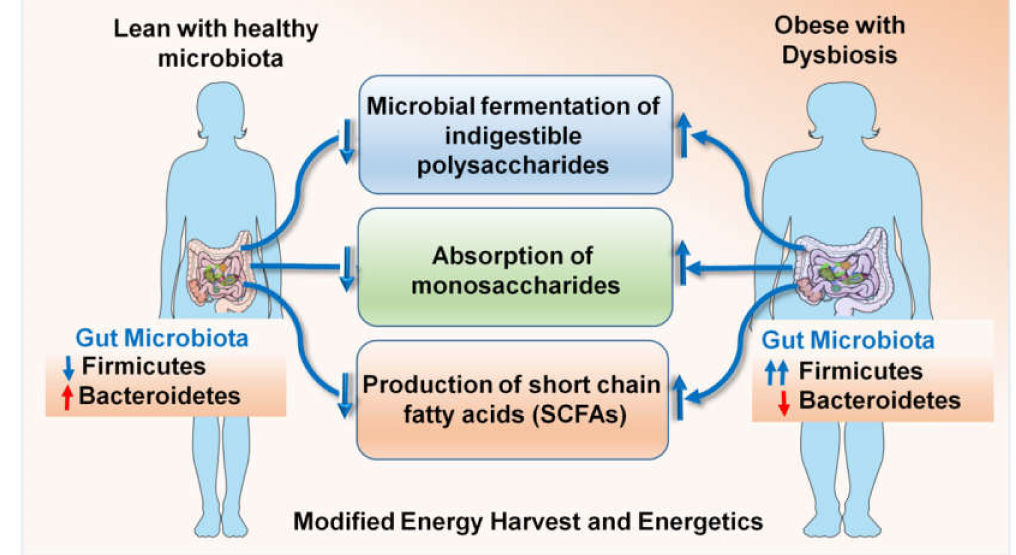
Figure 1. Microbial dysbiosis in obese states contributes to dysregulated energy harvest and